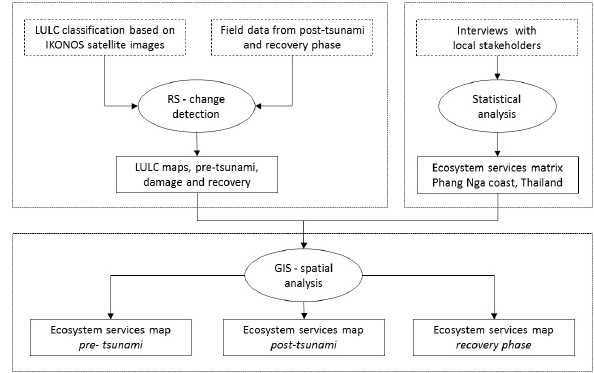
Fig. 2. Methodological approach for mapping changes in ecosystem service supply due to the impact of the 2004 Indian Ocean